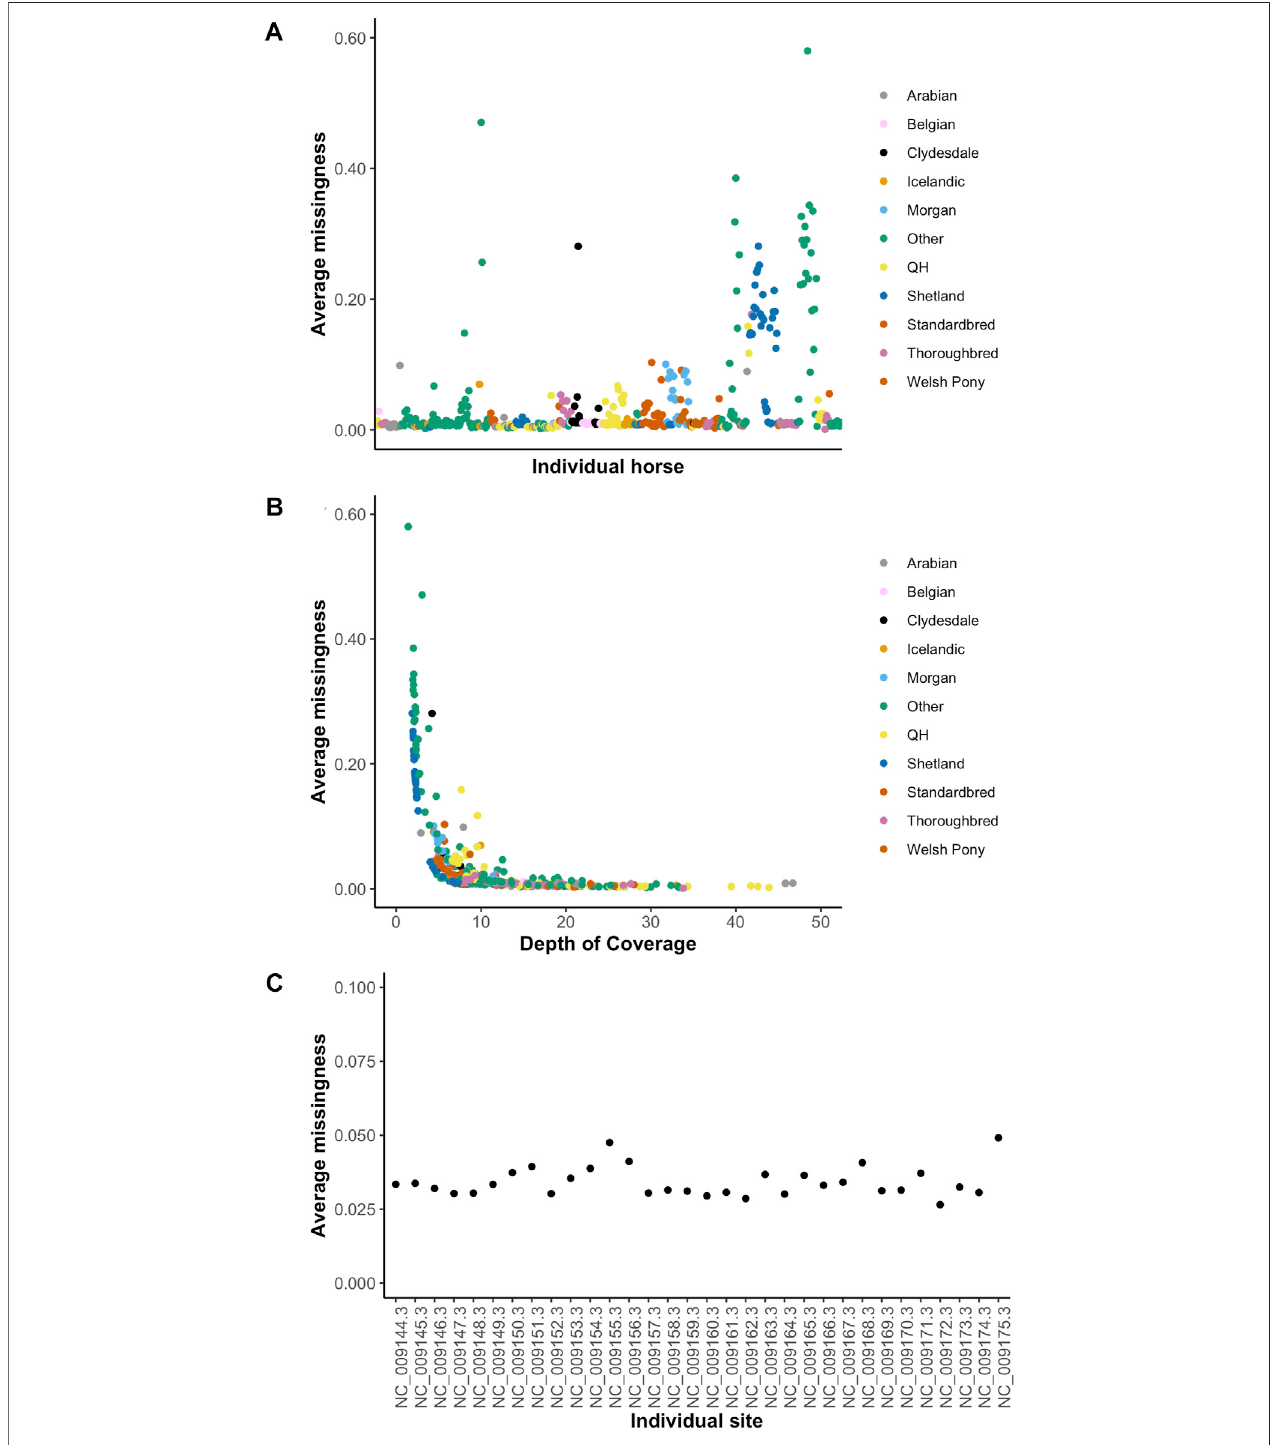
FIGURE 2 | Missingness by individual (A) , by depth of coverage (B) and by chromosome (C) . The 10 target breeds and other breeds are represented in colors shown in the fi gure legend in Figures 2A,B .